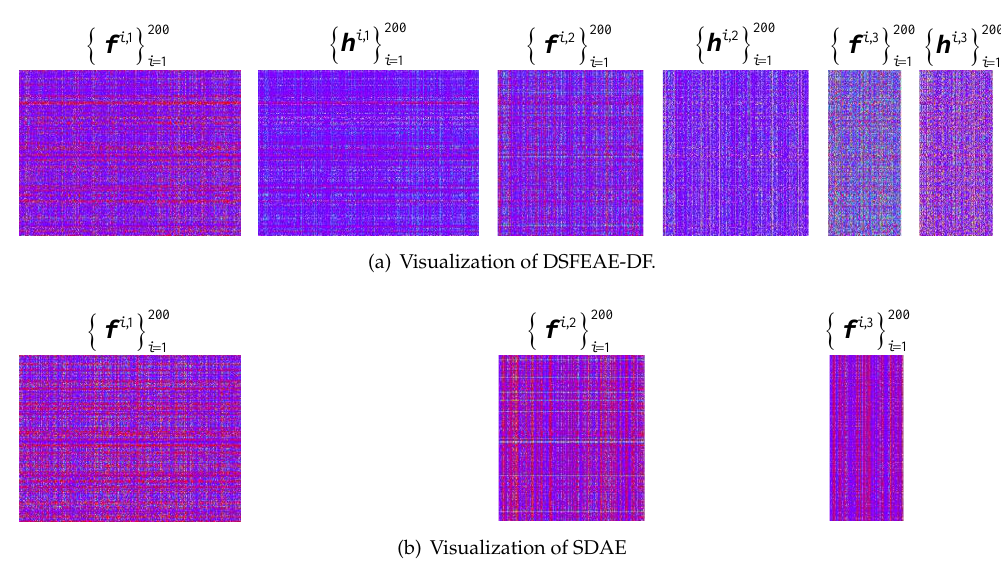
Figure 9. Visualization of DSFEAE-DF and stacked denoising autoencoder